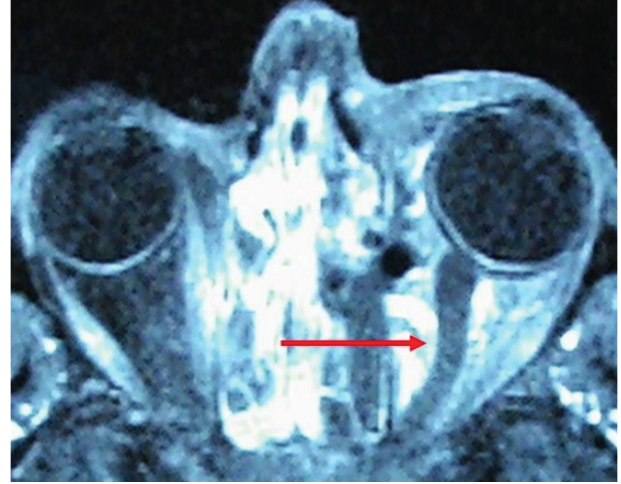
Additional Figure 1. MRI demonstrating the intact optic nerve (arrow) in the left eye in patient